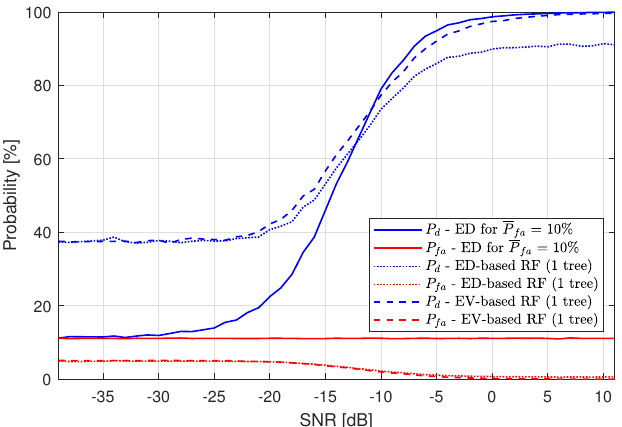
Figure 18. Resulting probabilities P d and P fa of applied Energy Detection-based Random Forest compared with Energy Vector-based Random Forest for ¯ P fa = 10% for different SNR values with a shadowing